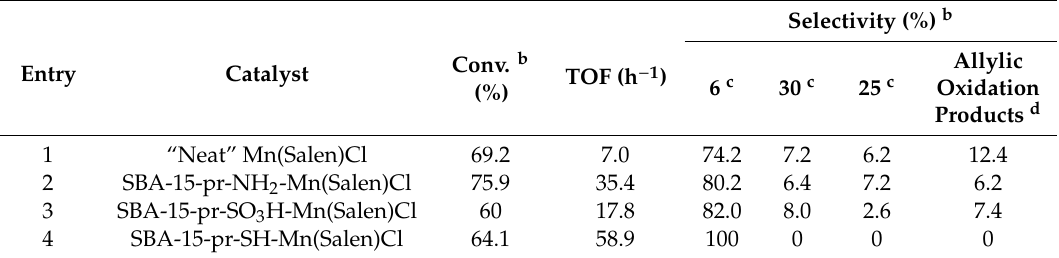
Table 6. Aerial oxidation of ( R )-( + )-limonene 2 over “neat” and immobilized Mn(Salen)Cl complexes a (adapted from reference Table 6. Aerial oxidation of ( R )-(+)-limonene 2 over “neat” and immobilized Mn(Salen)Cl complexes Table 6. Aerial oxidation of ( R )-(+)-limonene 2 over “neat” and immobilized Mn(Salen)Cl complexes a (adapted from reference [34]). Table 6. Aerial oxidation of ( R )-(+)-limonene 2 over “neat” and immobilized Mn(Salen)Cl complexes a (adapted from reference [34]). a (adapted from reference [34]).